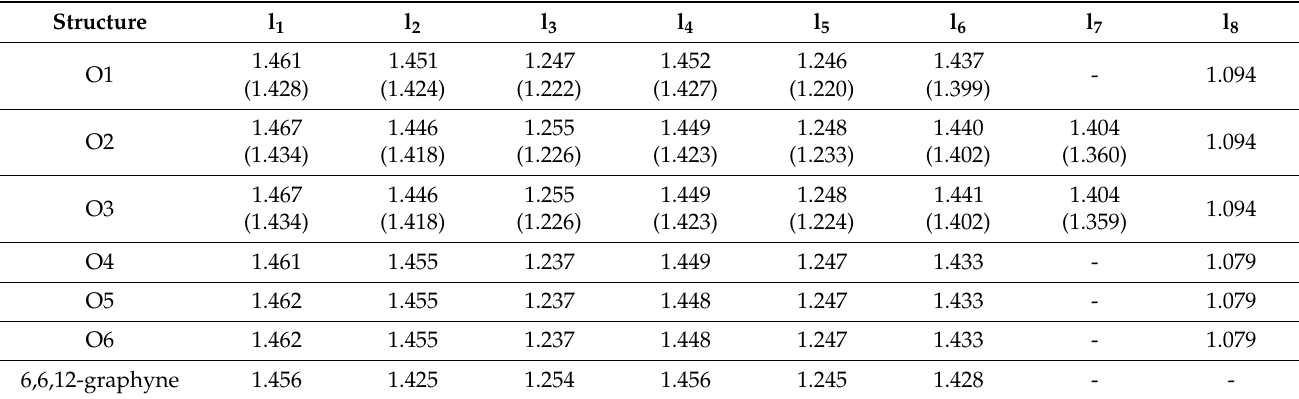
Table 1. Bond lengths (Å) in the different oligomers and 6,6,12-graphyne. Bond lengths l 1 , l 2 , l 3 , l 4 , l 5 , l 6 , l 7 , and l 8 are marked in Figures 2 and 3. The values in parentheses represent the experimental bond lengths [19].